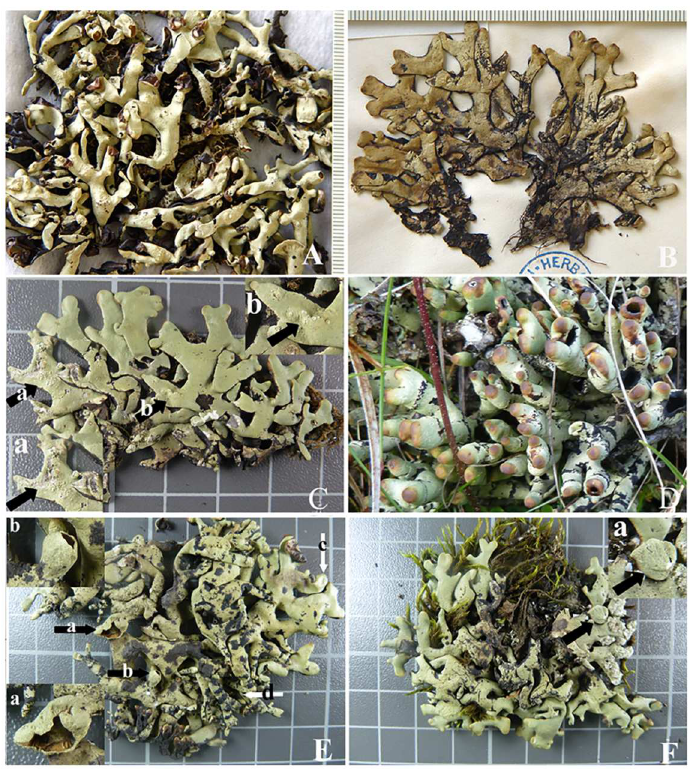
Fig 1. Morphology of the Hypogymnia hypotrypa group. A. Holotype of H . flavida (OSC). B. Lectotype of H . hypotrypa (BM). C. Soredia of H . hypotrypa , X. L. Wei W11135; a, b: soredia present only along the cracks of upper cortex. D. Fingerlikelobes of H . flavida , X. L. Wei W11188 (HMAS-L). E. H . flavida , X. L. Wei W11231 (HMAS-L); a, b: apothecia; c: wide lobes; d: fingerlikelobes. F. H . hypotrypa , wide lobes, X. L.